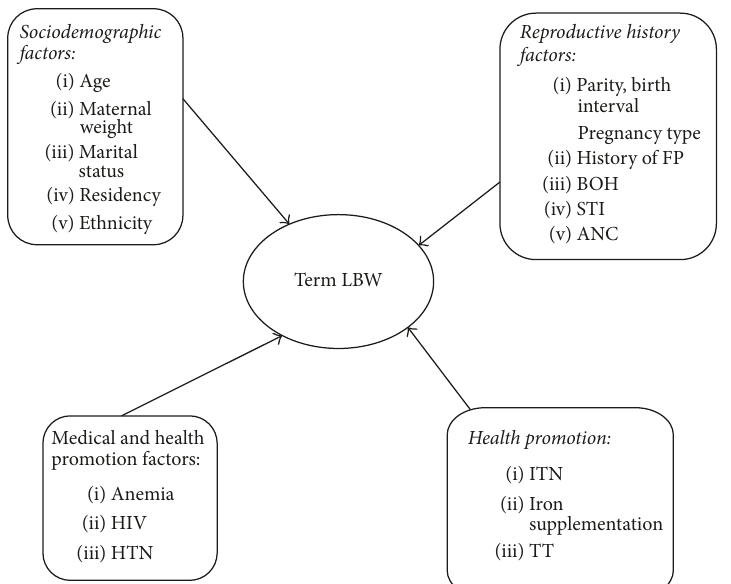
Figure 1: Conceptual framework to assess the prevalence and its associated factors of low birth weight among term neonates delivered in Adwa General Hospital, Northern